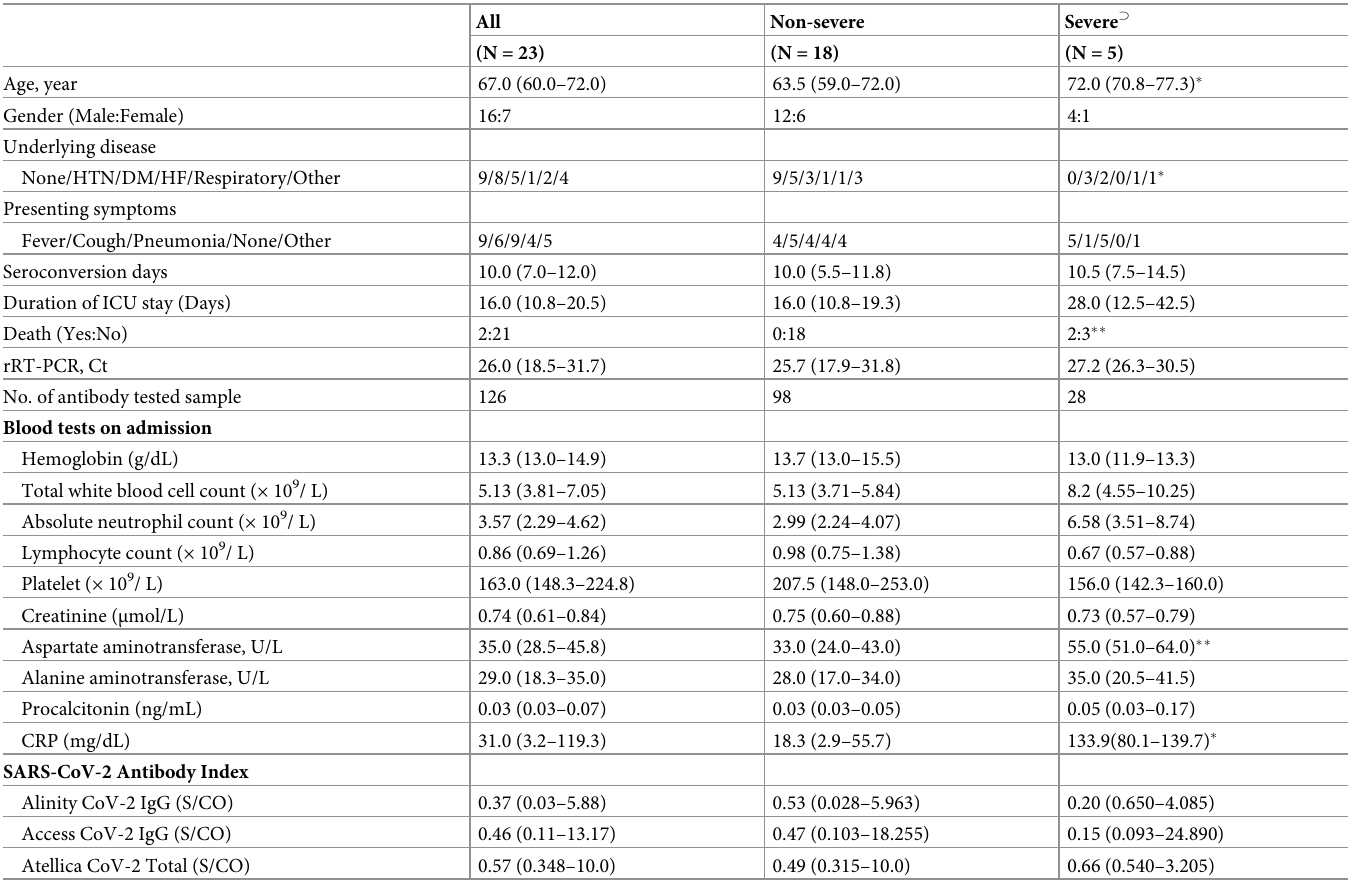
Table 2. Demographic laboratory characteristics of patients on